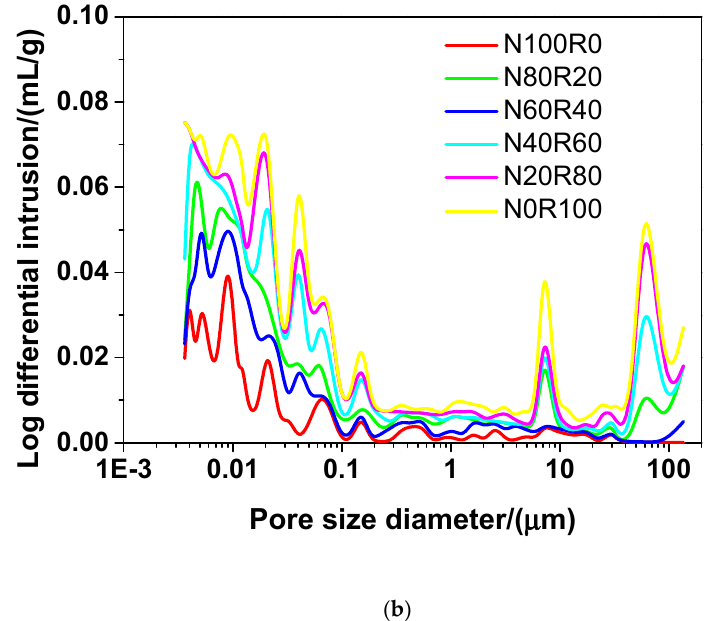
Figure 11. Porosity ( a ) and pore size distribution ( b ) of UHPC.